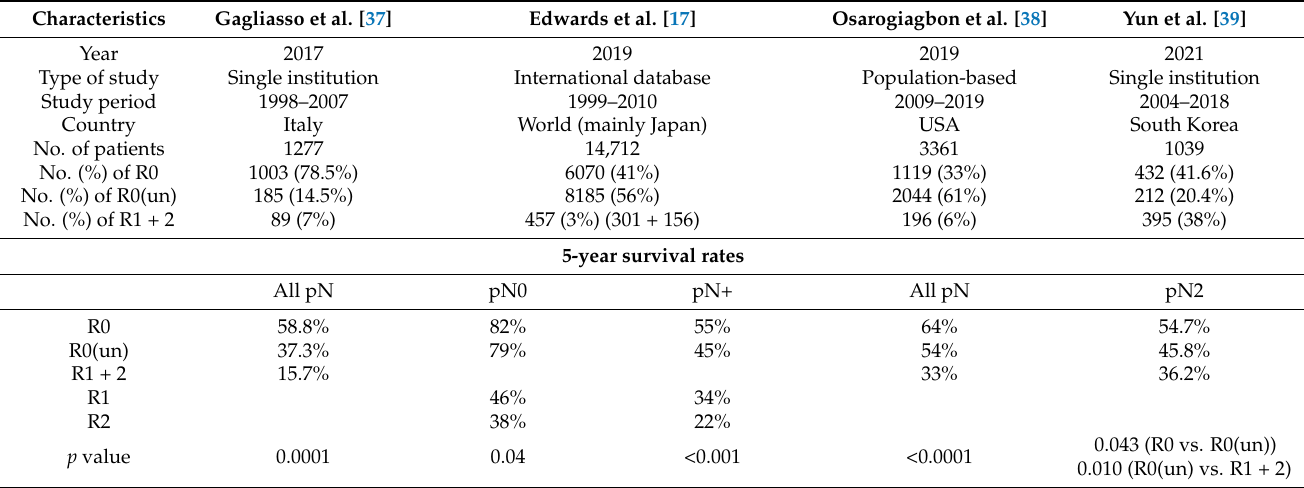
Table 4. Characteristics and survival rates of the published validations of the IASLC definitions of completeness of resection.